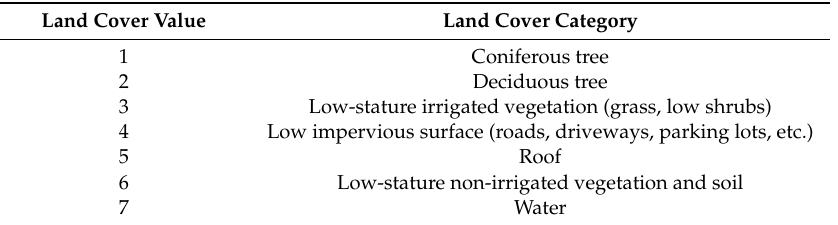
Table 1. Salt Lake County 1m LiDAR land cover data